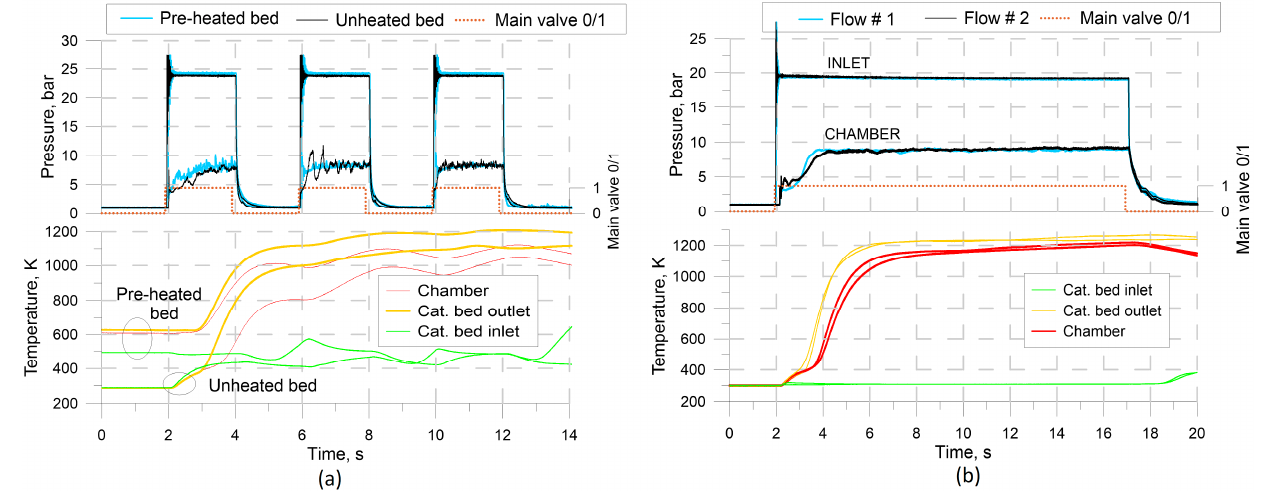
Figure 10. Starting characteristics (pressure and temperature profiles) of the catalyst bed comprising metal foam catalyst: ( a ) comparison of unheated and pre-heated catalyst in a pulse mode; ( b ) com- parison of two subsequent cold starts in 15 s constant firings.